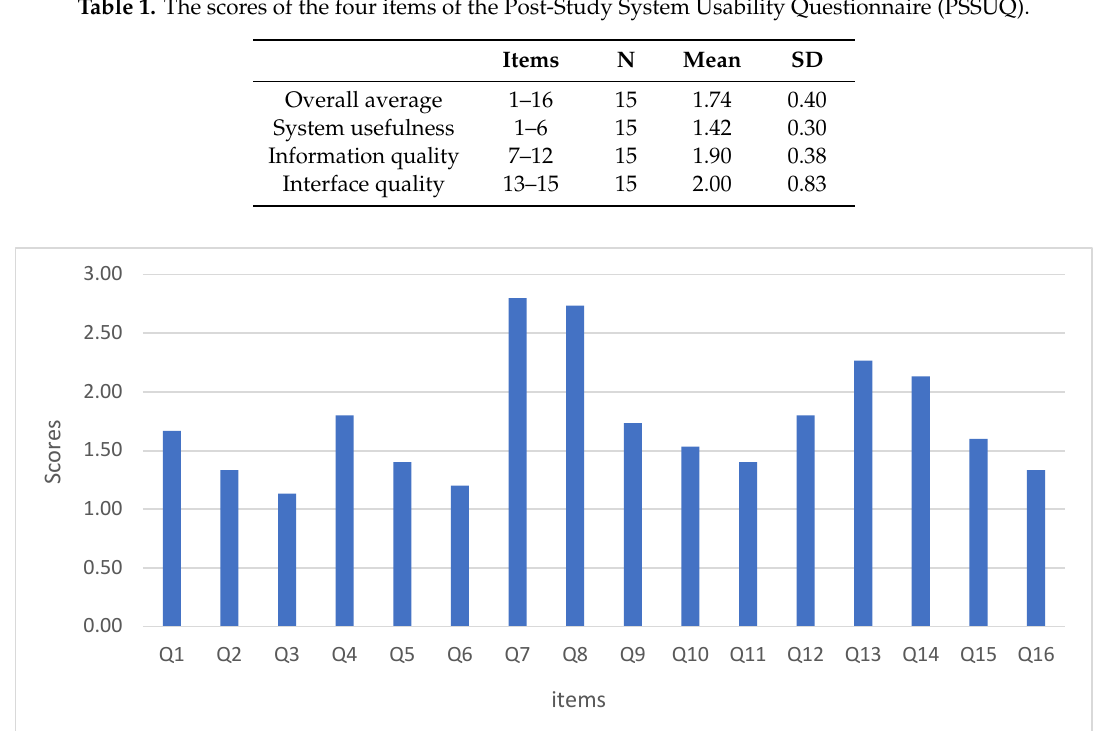
Figure 8. The average score for all topics in the PSSUQ.